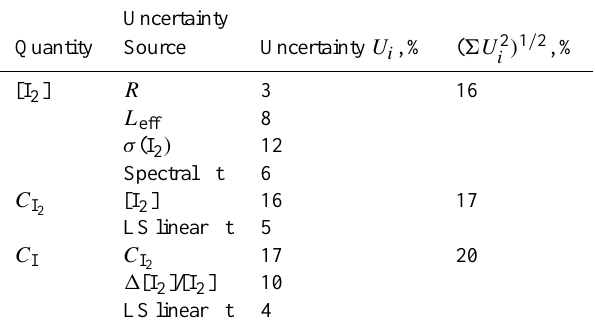
Table 4. Breakdown of the uncertainties associated with I 2 concen- tration and sensitivity factors.